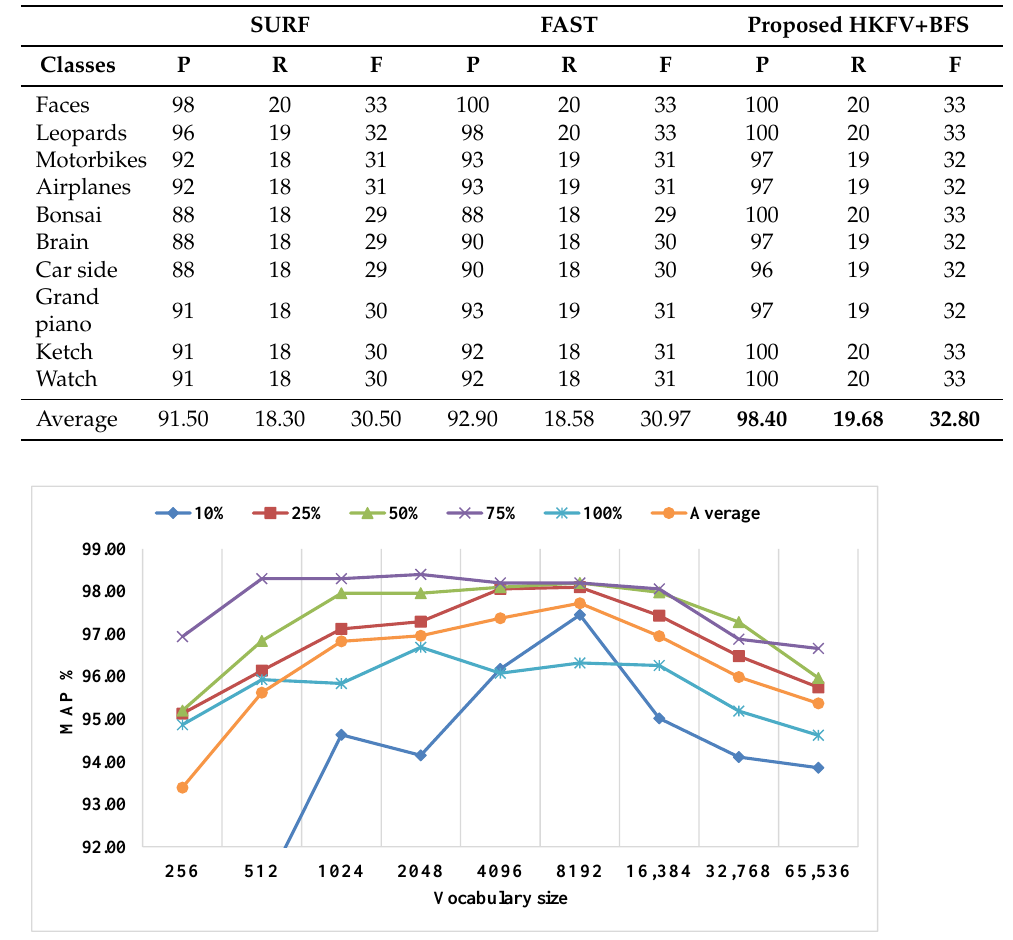
Table 7. HKFV with BFS vs. standalone SURF and FAST on Caltech-10 dataset classes. SURF FAST